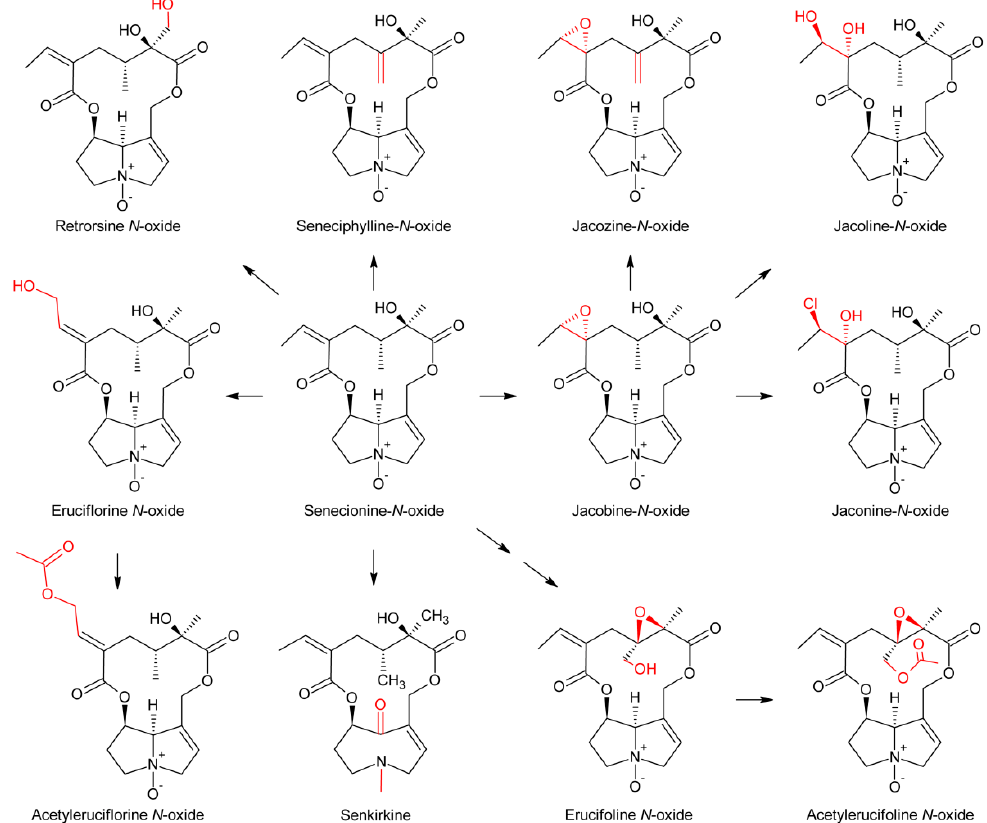
Figure 15. Diversification of senecionine-like PAs. Modifications of the senecionine N -oxide structure are shown in red. Adapted from Reference [116].